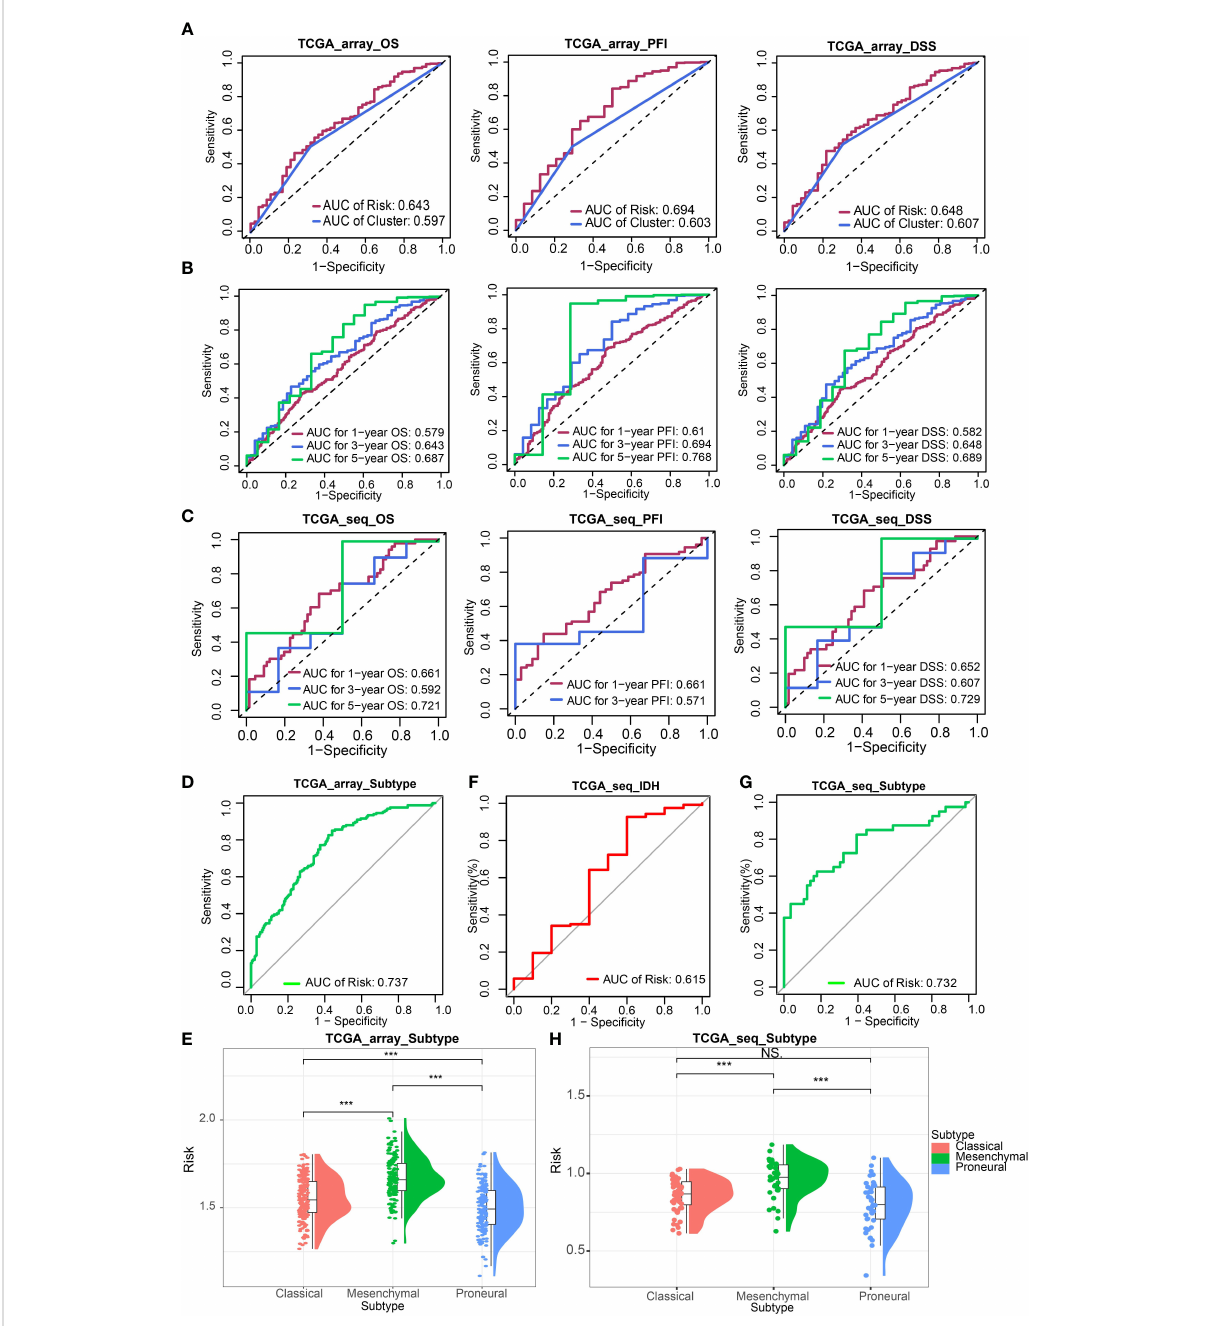
FIGURE 2 Validation of ICD-related risk signature. (A) AUC of survival prediction indicated the prediction ef fi cacy of risk signature was better than clusters. (B, C) AUC for 1 -, 3 -, and 5-year survival prediction in TCGA Array dataset (B) and TCGA Seq dataset (C) . (D) AUC for GBM subtypes prediction in TCGA Array dataset. (E) The risk scores of different GBM subtypes (classical, mesenchymal, proneural) in the TCGA Array dataset. (F) AUC for IDH status prediction in TCGA Seq dataset. (G) AUC for GBM subtypes prediction in TCGA Seq dataset. (H) The risk scores of different GBM subtypes in the TCGA Seq dataset. NS, non-signi fi cant. ***P <